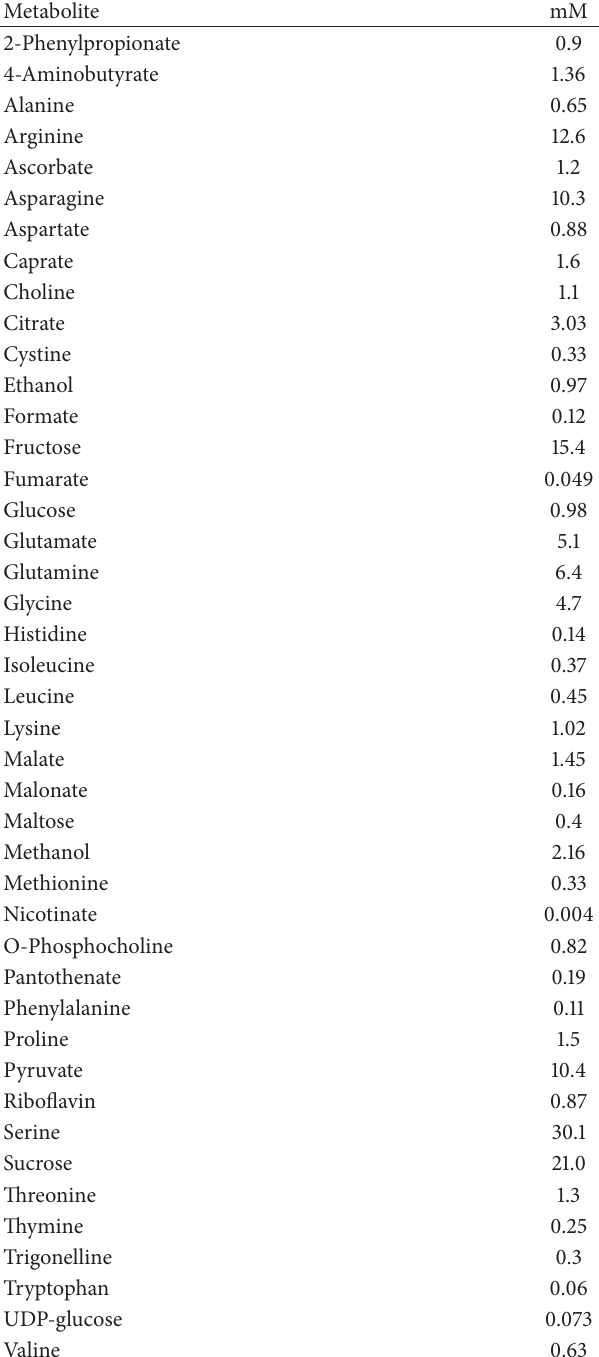
Table 4: Average metabolites molar concentration of red garlic of